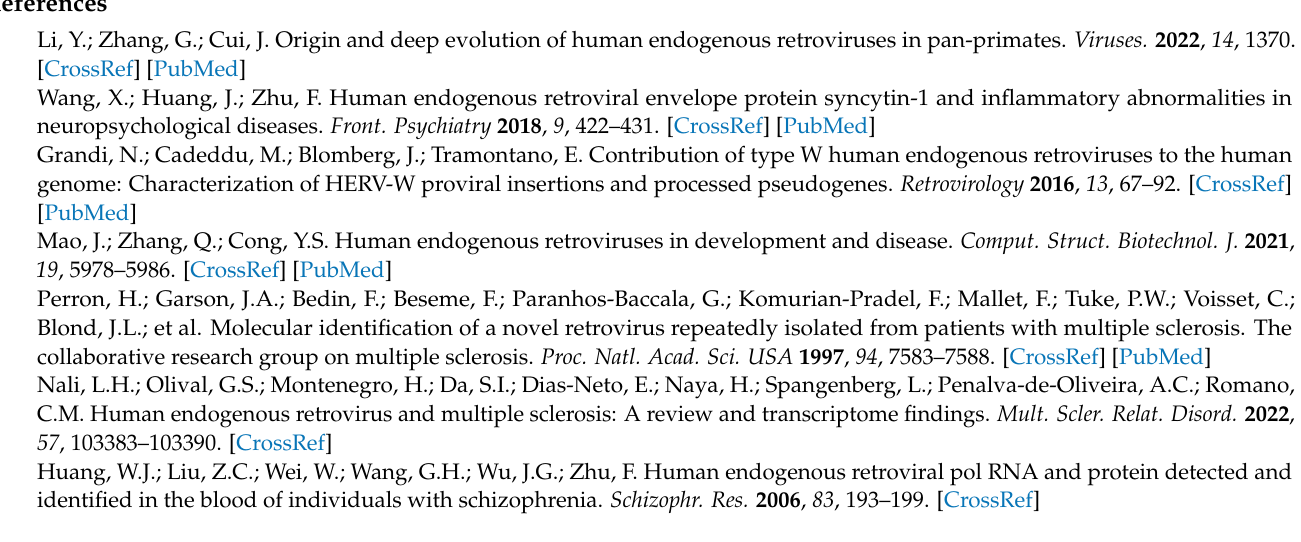
Table S4: Antibodies and the dilutions, Table S5 : The concentration of Wnt5a in the blood of con- trol and schizophrenia patients, Table S6 : The concentration of RAC1 in the blood of control and schizophrenia patients, Table S7: The concentration of WAVE1 in the blood of control and schizophre- nia patients, Table S8: The concentration of Arp2 in the blood of control and schizophrenia pa- tients, Table S9: The concentration of ERVWE1 in the blood of control and schizophrenia patients, Figure S1: The concentration of RAC1 and WAVE1 in the control groups and the schizophrenia patients, Figure S2: The expression of Arp2 in schizophrenia patients according to bioinformatics, Figure S3: The concentration of Wnt5a and Arp2 in the ERVWE1-positive schizophrenia and the ERVWE1-negative schizophrenia, Figure S4: Wnt5a was a target of miR-141-3p, Figure S5: ERVWE1 had no effect on Arp3 expression, nor on Wnt/ β -catenin or Wnt/CAMK2A signaling pathways, Fig- ure S6: ERVWE1 and miR-141-3p did not affect the expression of Wnt/ β -catenin nor Wnt/CAMK2A signaling